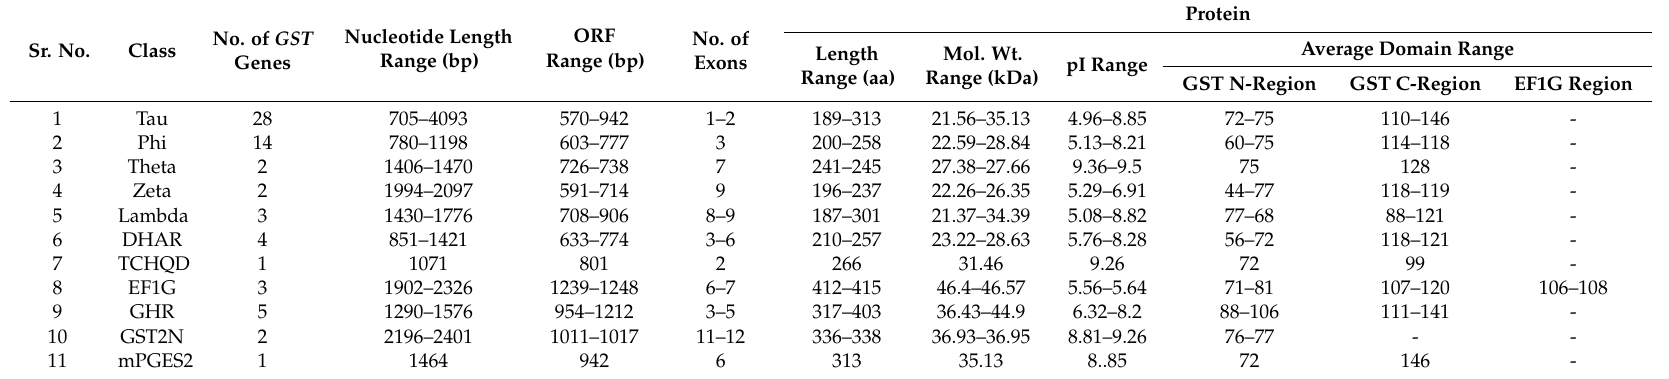
Table 2. Characterization of GST genes in Brassica oleracea .